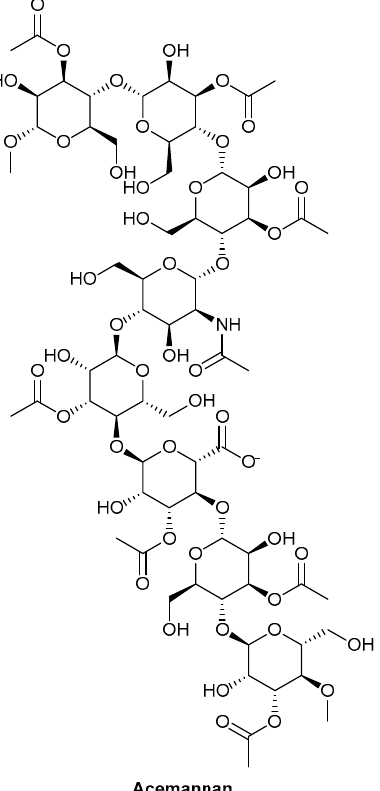
Figure 10. Photo of Aloe vera (L.) Burm.f. (copyright held by Royal Botanical Gardens, Kew).